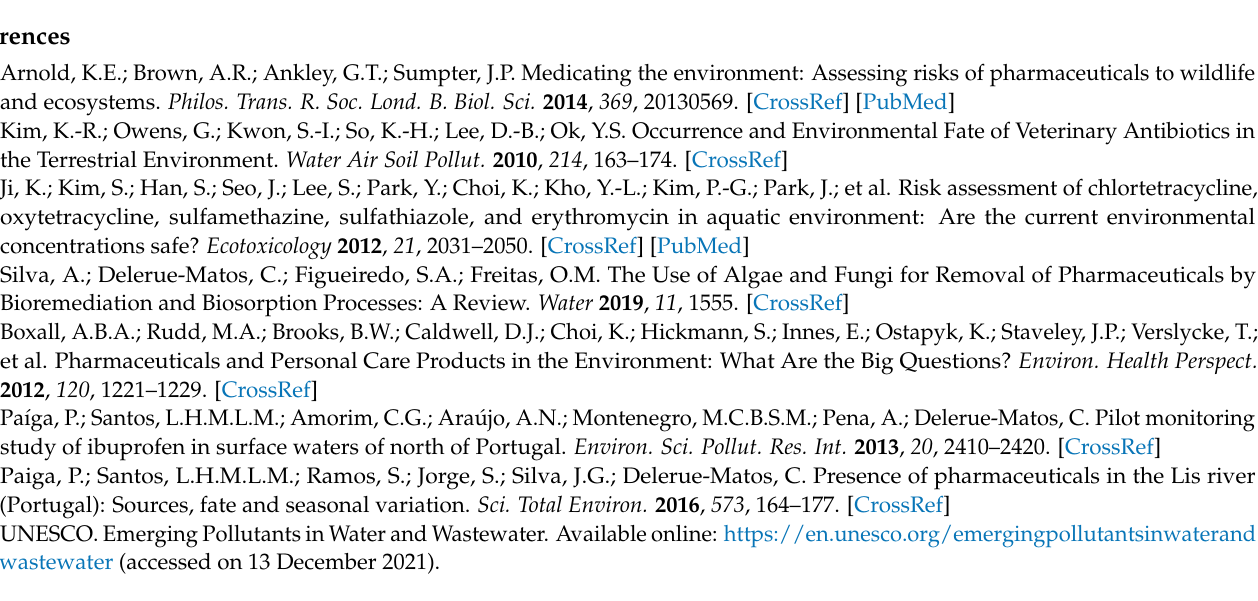
Table S2: List of reagents used in the study, Table S3: Band assignments of FT-IR spectrum of alder sawdust, Table S4: pH and temperature values recorded at the beginning and the end of batch